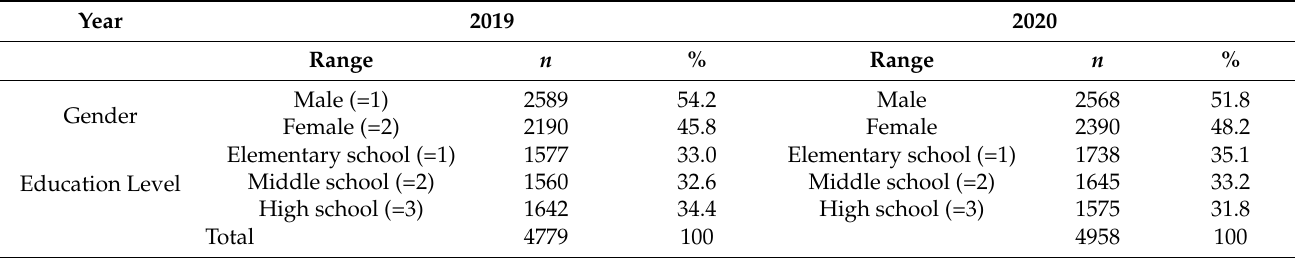
Table 1. Socio-demographic characteristics of the